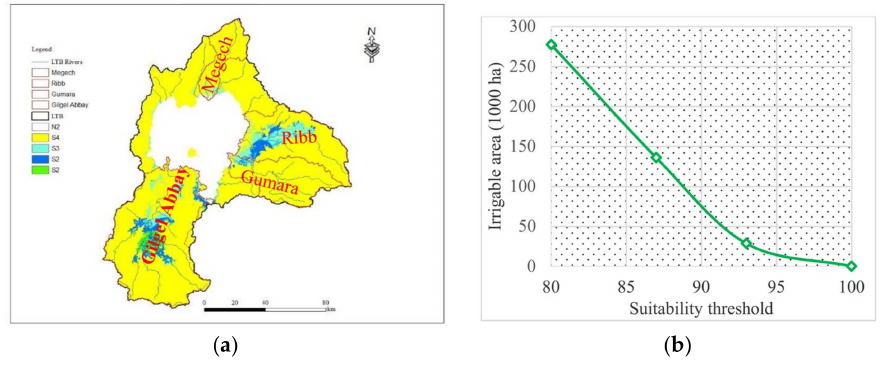
Figure 13. Irrigable land from groundwater ( a ) 85% threshold; and ( b ) various